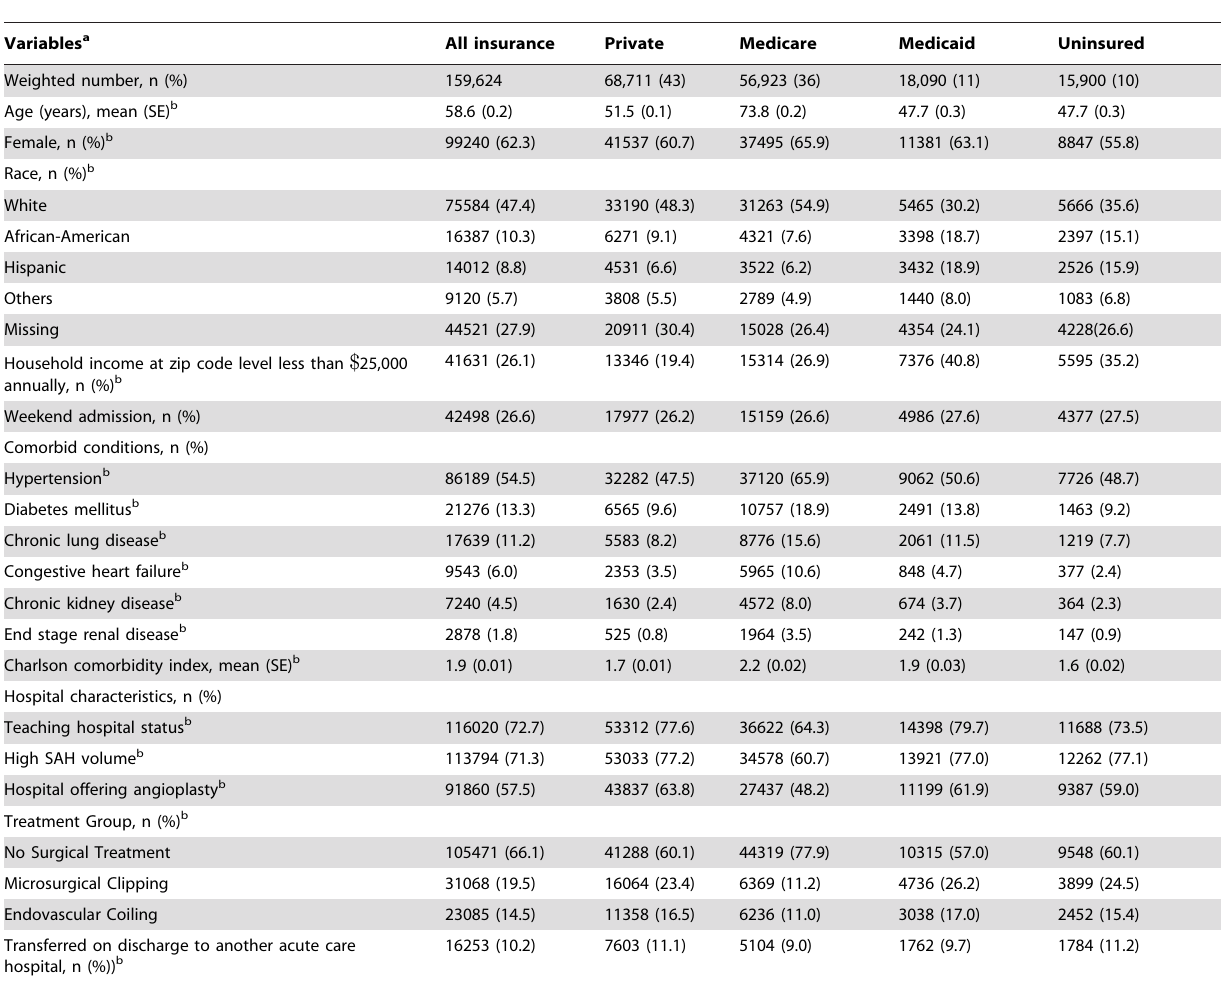
Table 1. Demographics, Socioeconomic Measures, Comorbid Conditions and Treatment Allocation for Patients with Subarachnoid